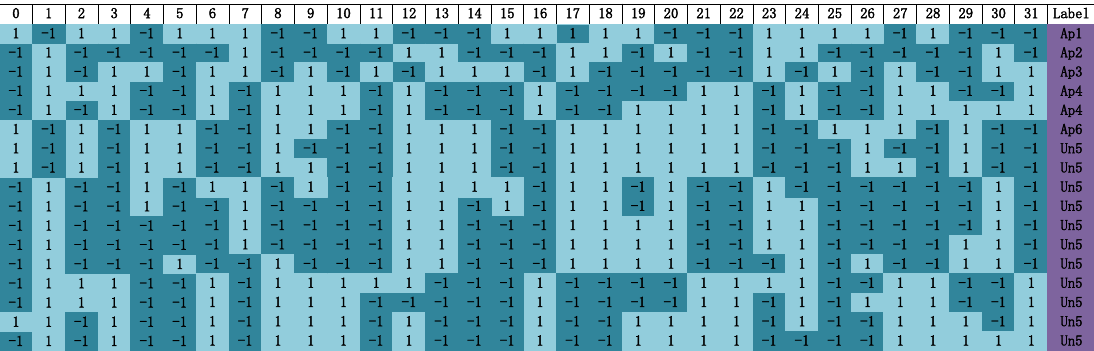
Figure 9. The 32-bit encoding results of DPSH method with the unidentified